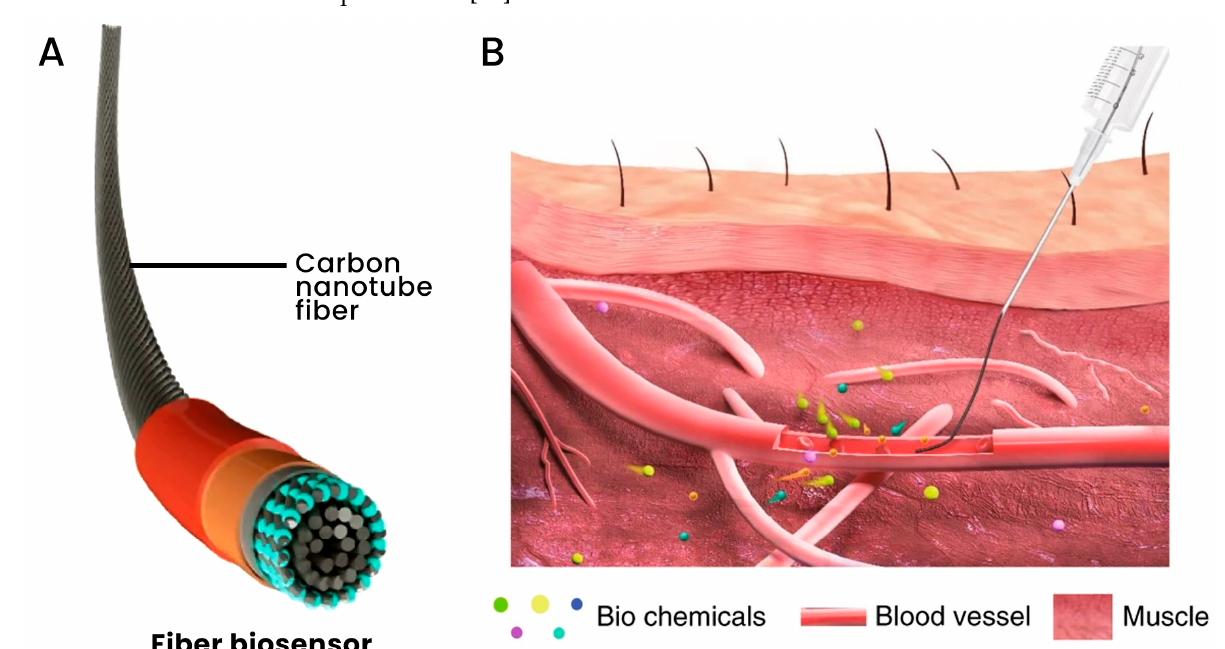
Figure 5. Carbon nanotubes (CNT) fibers-based implantable biosensor. ( A ) Structure of the CNT assembly and formation of the electrode with recognition and insulation layers. ( B ) Implantation of the CNT fiber-based biosensor for local monitoring. Reproduced with permission from ref. [65]. ©2020 Nature Publishing Group.